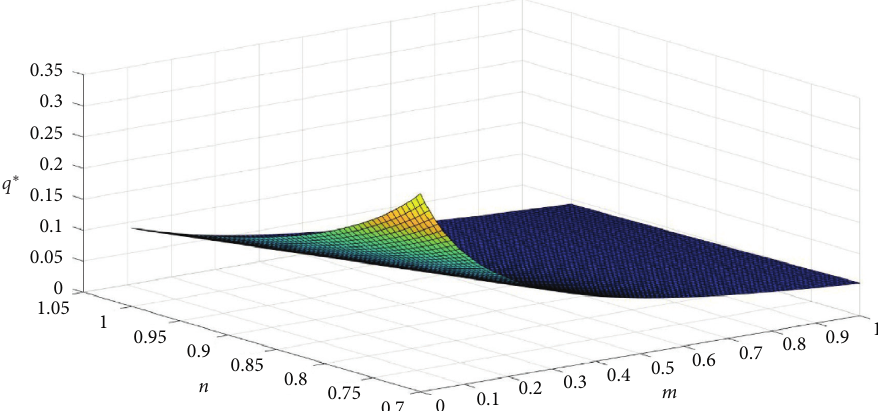
Figure 4: Simulation diagram of the influence of project success rate and variation of project success rate on optimal rent-seeking probability q ∗